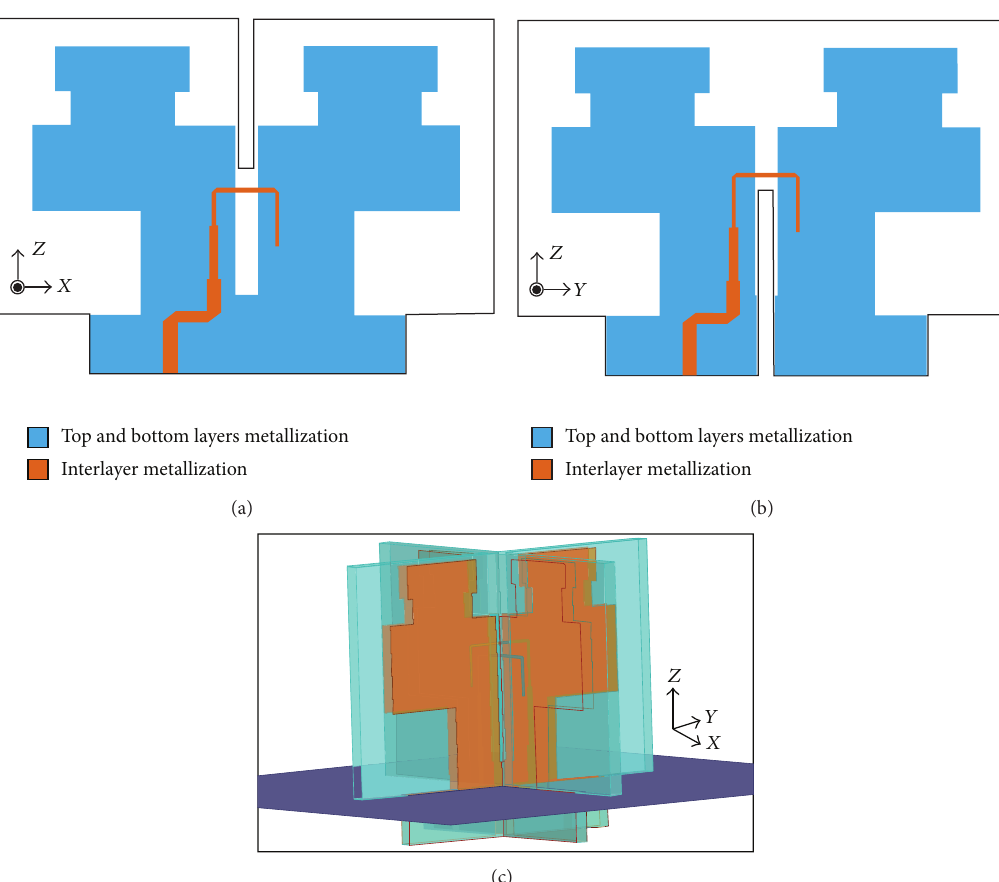
Figure 4: Geometry of the dual-polarized printed dipole antenna: (a) the dipole with a shorter balun and a slot on the upper part of the substrate; (b) the dipole with a longer balun and a slot on the lower part of the substrate; and (c) the geometry of the mounted dual-polarized printed dipole